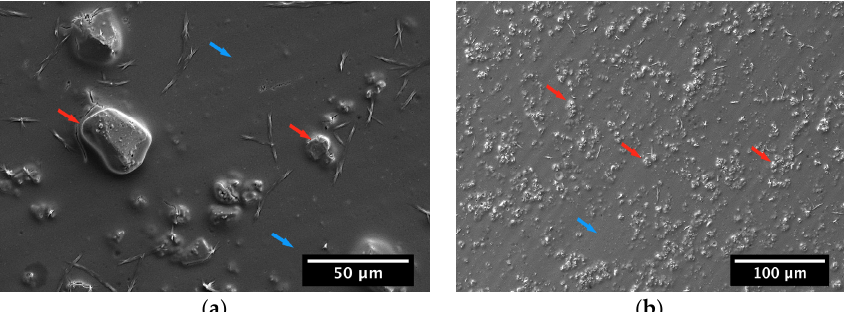
Figure 5. SEM images showing the microstructure of EPD films produced with ( a ) Cu ‐ doped 45S5 BG/zein and ( b ) 45S5 BG/zein at two magnifications, showing BG particles (red arrow) embedded in zein (blue arrow) on the surface of the coatings.